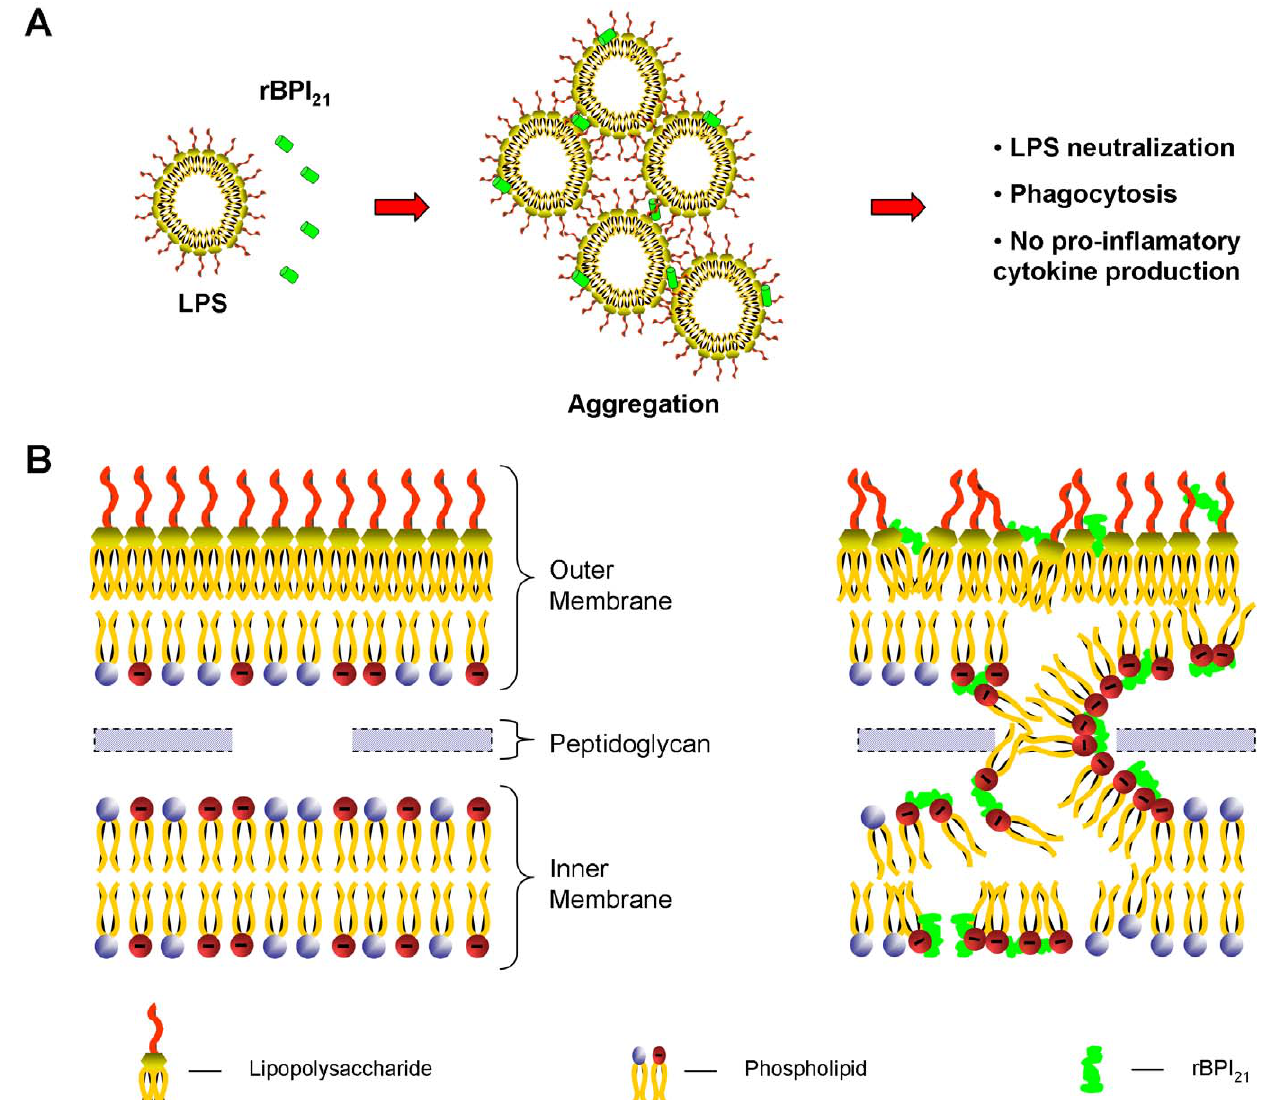
Figure 8. Schematic representation of the proposed mechanism of action of rBPI 21 protein. A) The protein interacts with LPS aggregates promoting their aggregation, which allow LPS phagocytosis by innate immune cells and reduce LPS availability for its receptor. B) rBPI 21 interacts electrostatically with the LPS of the outer leaflet of outer membrane. This interaction disrupts the higher tight bond of the LPS, which allow the peptide insertion and translocation to the outer membrane inner leaflet and to the intermembrane space. rBPI 21 induces the fusion (or hemifusion) of the inner leaflet of the outer membrane and the inner membrane (both rich in PG), following a process similar to the occurring at the Bayer junctions [41]. These membrane fusion events promote an increased membrane permeability, culminating with the leakage of the bacterial